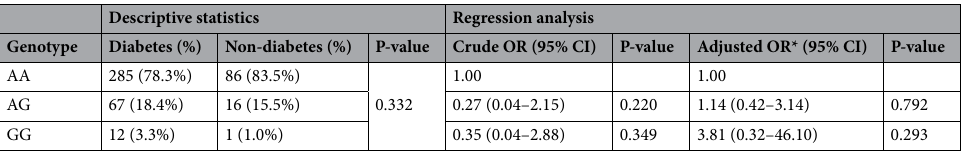
Table 4. Association of CNR2 -rs2501391 with T2DM in the UAE population. *Multivariate logistic regression adjusted for age, gender and logBMI.